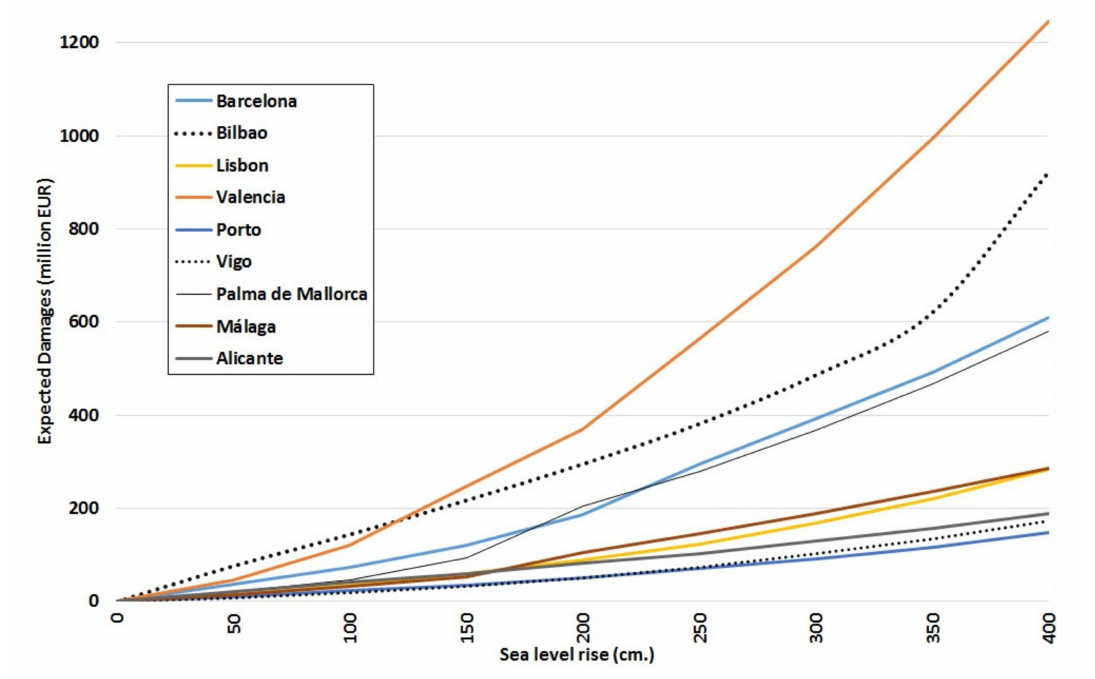
Figure 5. Deterministic damage curves for nine cities based on data by